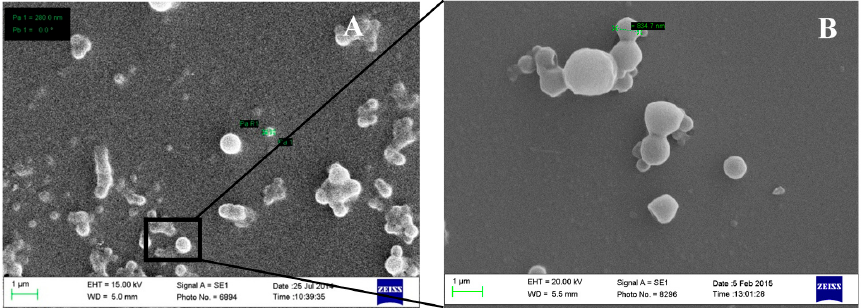
Figure 5. SEM of formulation (sample number pleased) showing individual and agglomerated nanoparticles at low ( A ) and high ( B ) magnifications.